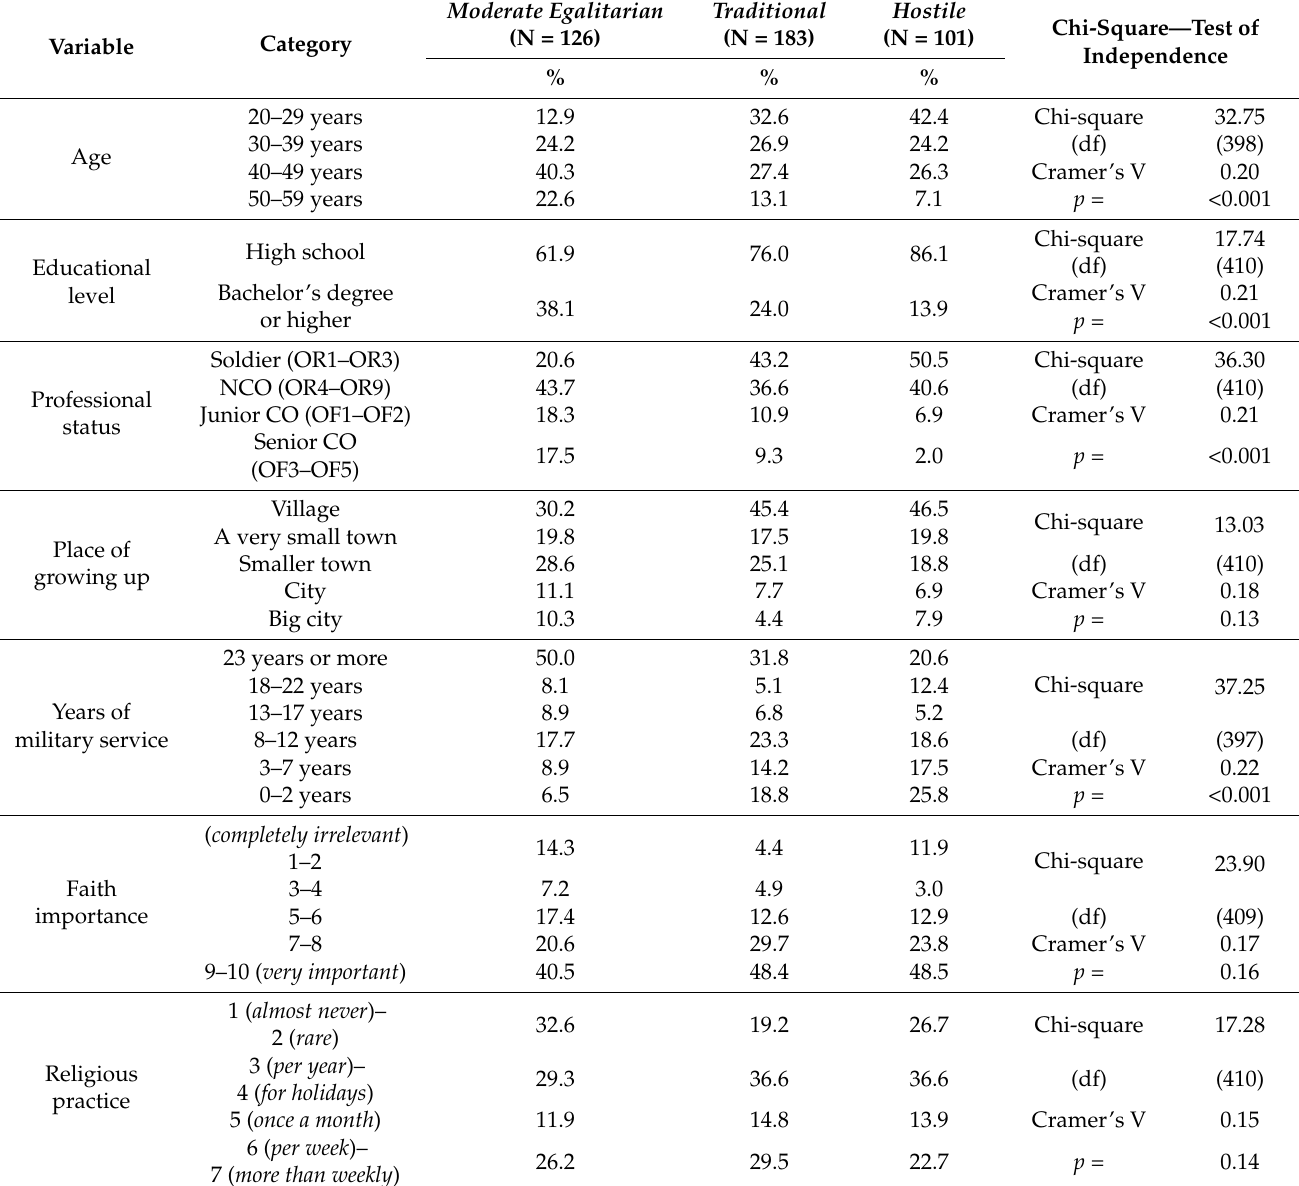
Table 10. Differences in men’s sexism endorsement types according to personal